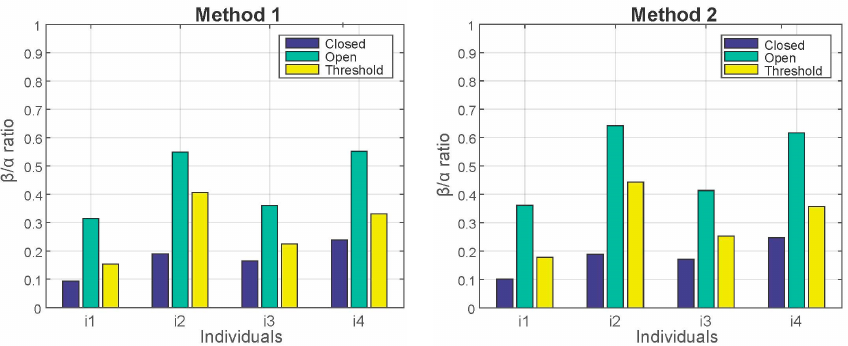
Figure 2. β / α ratio of each eye state for methods 1 and 2 and its corresponding threshold level.